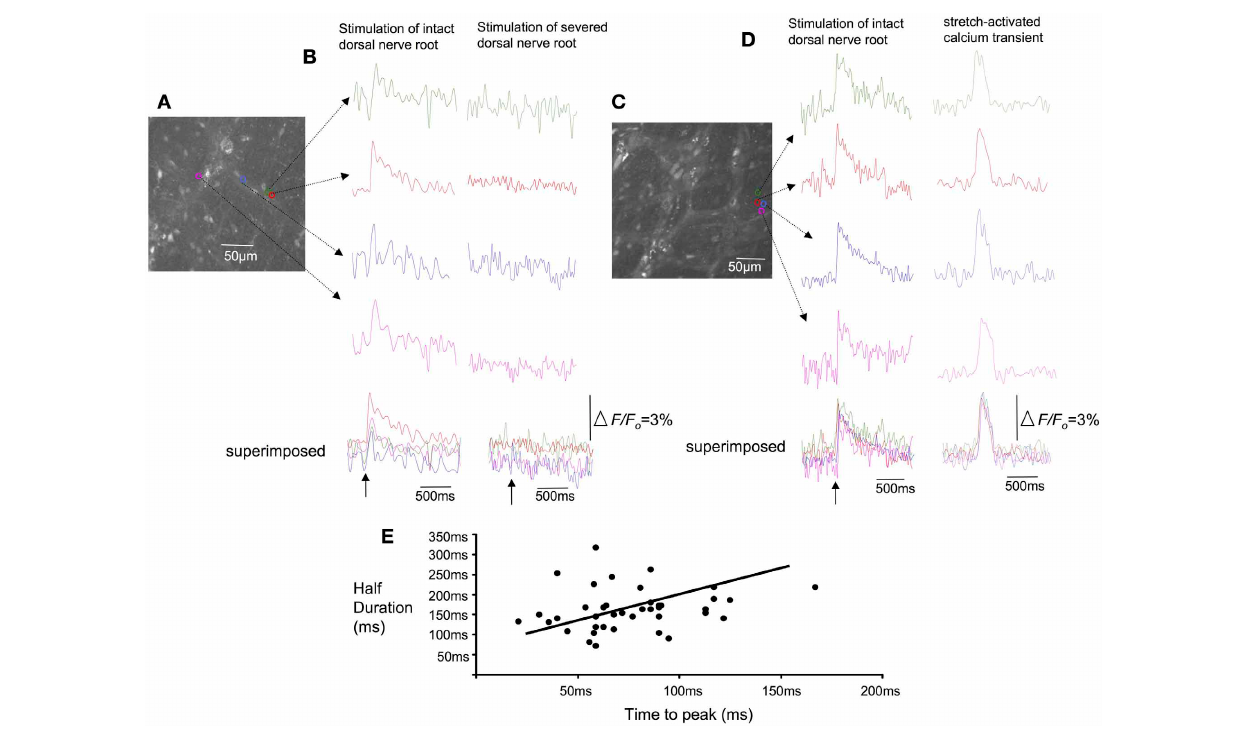
FIGURE 6 | Effects of selective electrical nerve stimulation applied to dorsal (afferent) nerve roots on calcium induced fluorescence changes in rectal afferent nerve endings in colonic myenteric ganglia. (A) Photomicrograph of the region of interest from which calcium transients were recorded in this single myenteric ganglia. (B) Single pulse (70V, 0.4ms) electrical stimuli applied to dorsal nerve roots arising from L6-S2 evoked brief calcium transients in axon varicosities within myenteric ganglia (left hand panel). When the dorsal roots were lesioned (right hand panel), the same stimulus failed to evoke any response. (C) Shows a micrograph of a single myenteric ganglion from another preparation. (D) Electrical stimulation (single pulse: 0.4ms, 70V) applied to L6-S1 DRG